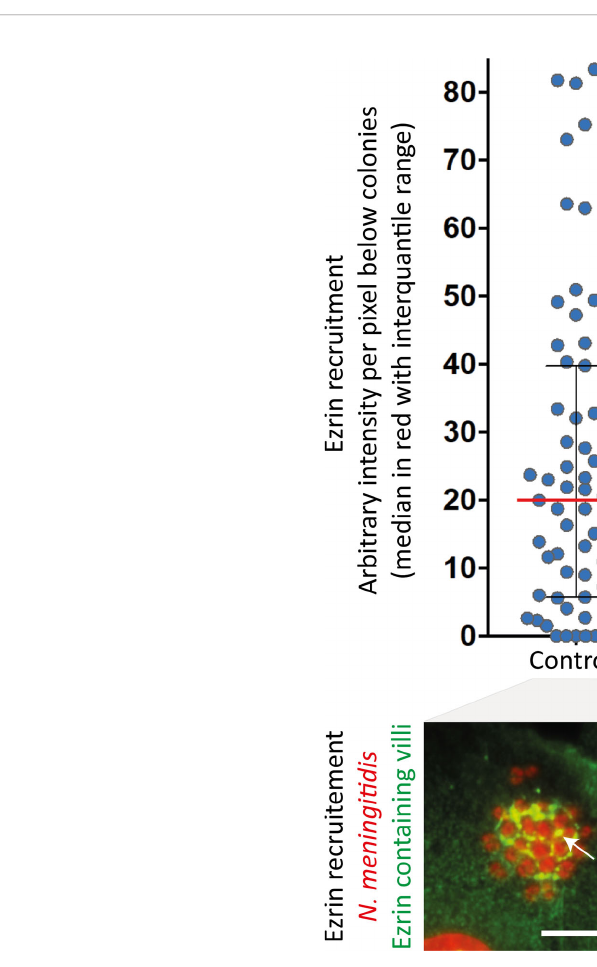
FIGURE 2 | Pertussis toxin inhibits meningococcus-induced signalling. Endothelial hCMEC/D3 cells were infected with wild type N. meningitidis and submitted to centrifugal forces with or without pertussis toxin pre-incubation (PTX - 20ng/ml). Cells were then processed for the analysis of ezrin recruitment under bacterial colonies. Top panel: the intensity of ezrin recruitment was quanti fi ed for each individual colony and expressed as arbitrary units per pixel under colonies (as in 30). Each dot represents one colony. Median values (in red) with interquartile range are shown. A Mann-Whitney test was used to determine signi fi cant differences between median values. p=0.0002. Bottom panel: Representative immuno fl uorescence images. HCMEC/D3 cell nuclei and bacterial DNA (small, grouped dots) were labelled with DAPI (red); anti-ezrin antibodies stained ezrin (green). Arrows pointed at ezrin-enriched villi. Bar: